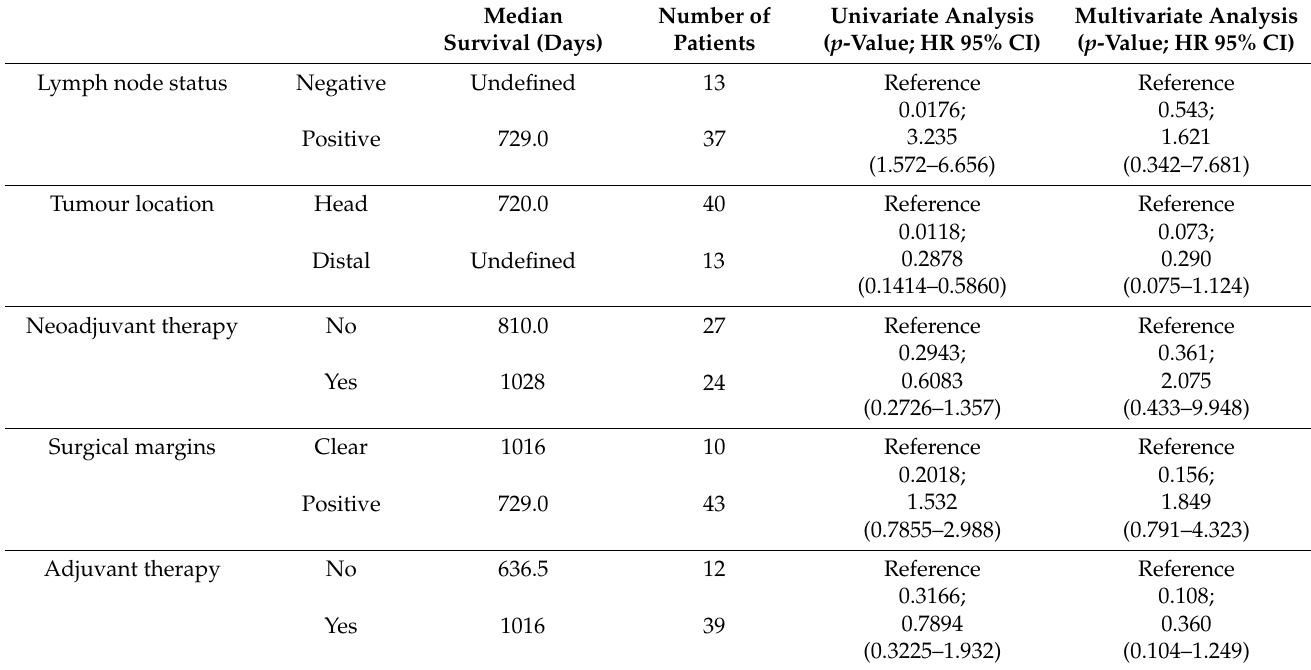
Table 5: Independent prognostic factors. Median survival and significance displayed for each group with extra surgical factors in patients who received surgery. Univariate analysis performed using log-rank test; multivariate analysis performed using Cox proportional hazards model. Multivariate analysis for lymph node status, tumour location, neoadjuvant therapy, margin status and adjuvant therapy performed with the surgery group. HR, hazard ratio; 95% CI, 95% confidence